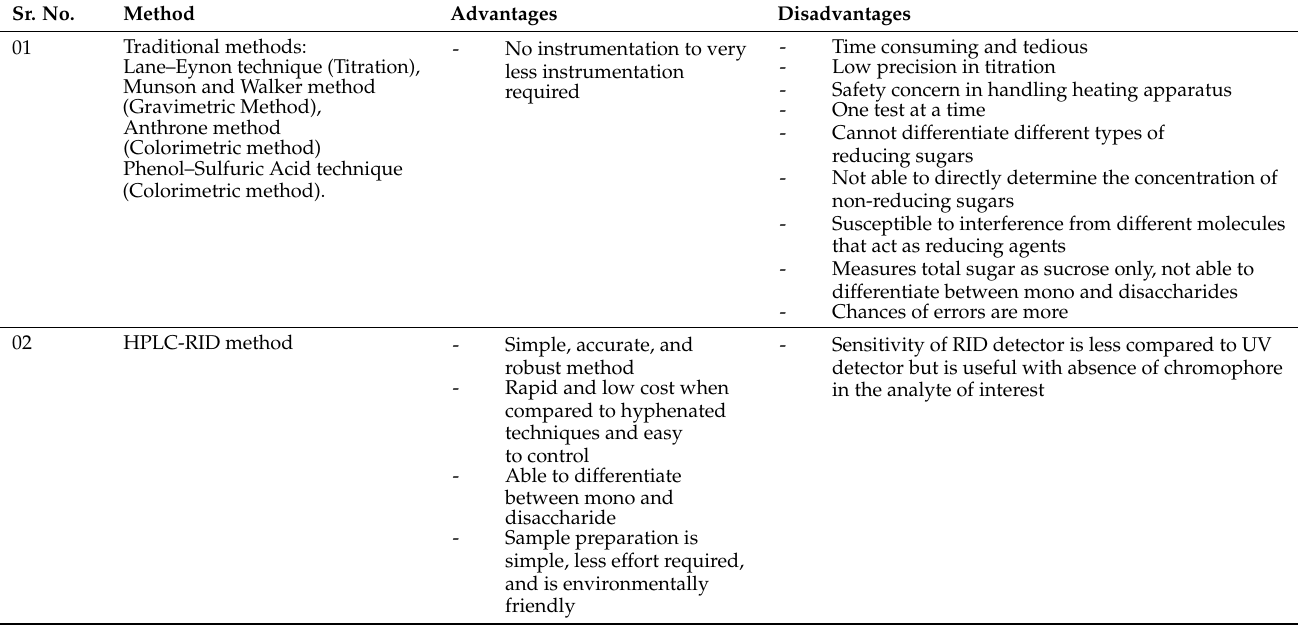
Table 1. Summary of the different methods of sugar